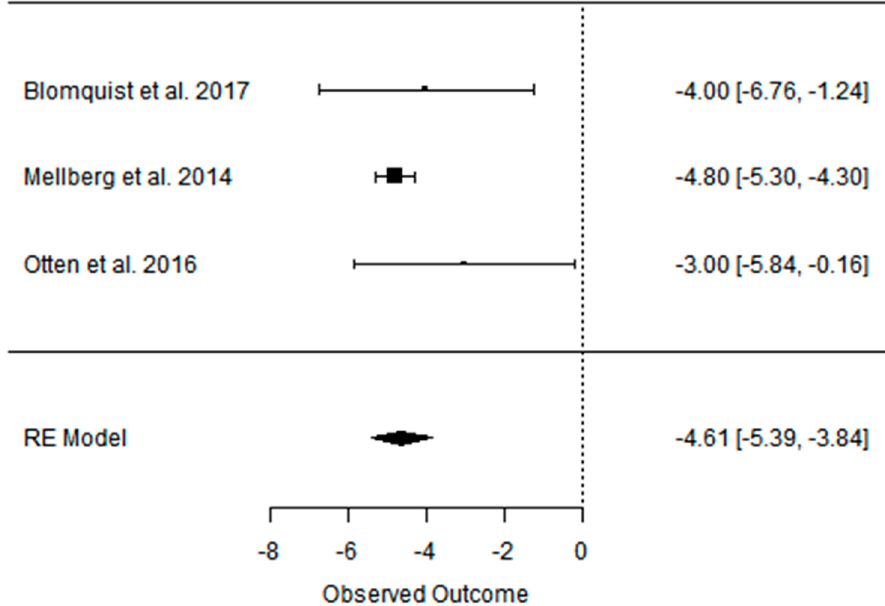
Figure A42. Forest plot of the effect of a PD on DBP in the long term (weighted mean difference).